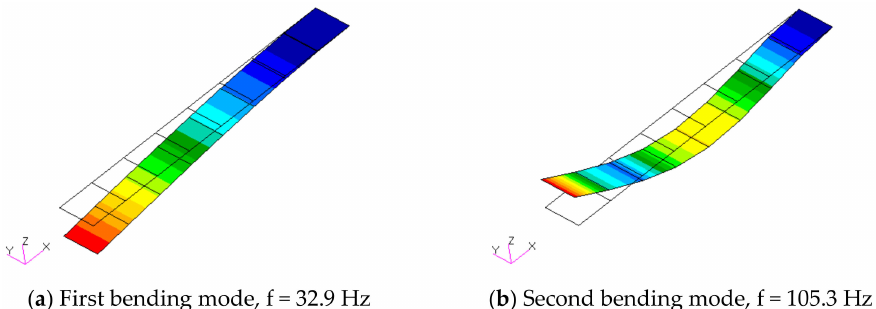
Figure 4. Mode shapes of the metallic bar.